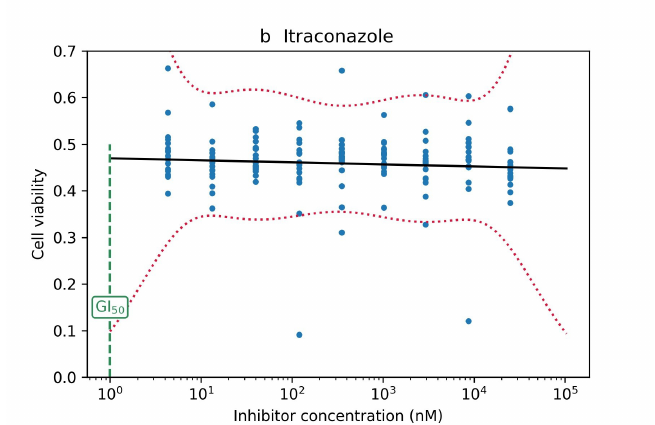
Figure 7. ( a ) Bortezomib showed an effect very early, at concentrations for which there were no measurements, so the confidence band was very wide. ( b ) Itraconazole did not have an effect, and the numeric algorithm failed to fit a logistic curve to the empirical data.